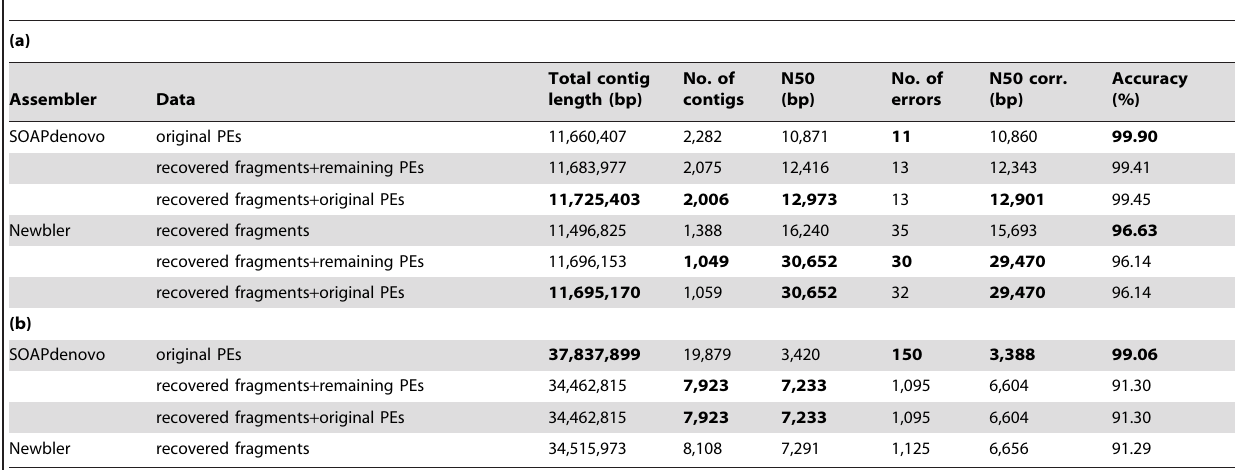
Table 9. Statistics of SOAPdenovo and Newbler assemblies on three types of real data of two fungi.